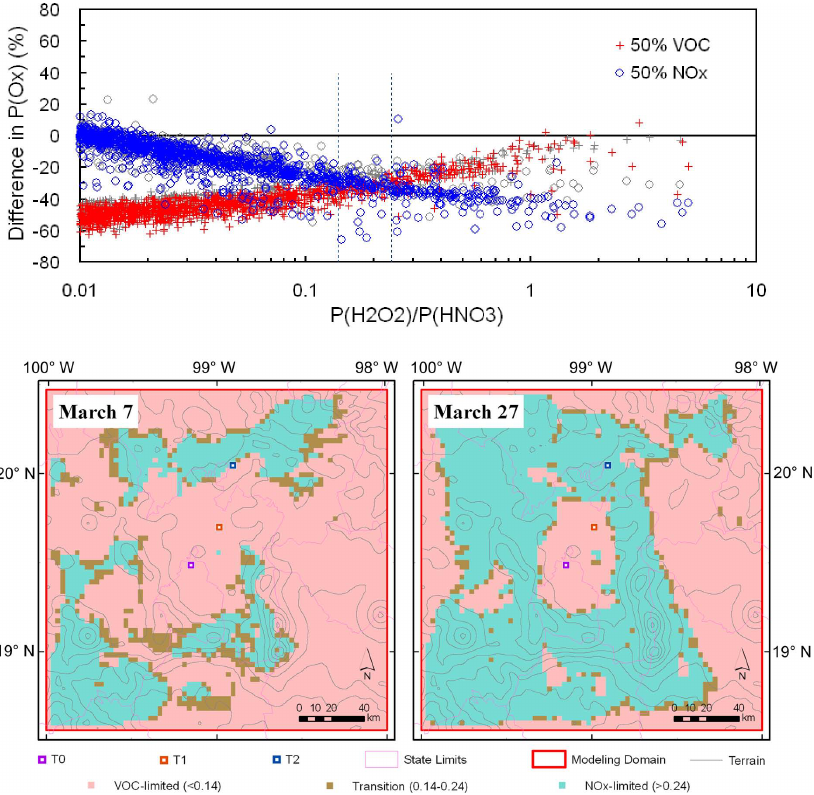
Fig. 11. Top panel: The percentage change in O x formation rate as a function of the indicator, ratio of H2O2 production rate to HNO3 production rate at 12:00–17:00LT during the episodes (weekends are shown in gray) within the urban area. The dashed bars envelop the transition regime. Bottom panel: Spatial distribution of the ratio at 14:00LT on 7 and 27 March 2006 indicating the NO x -VOC sensitivity (source: Song et al.,